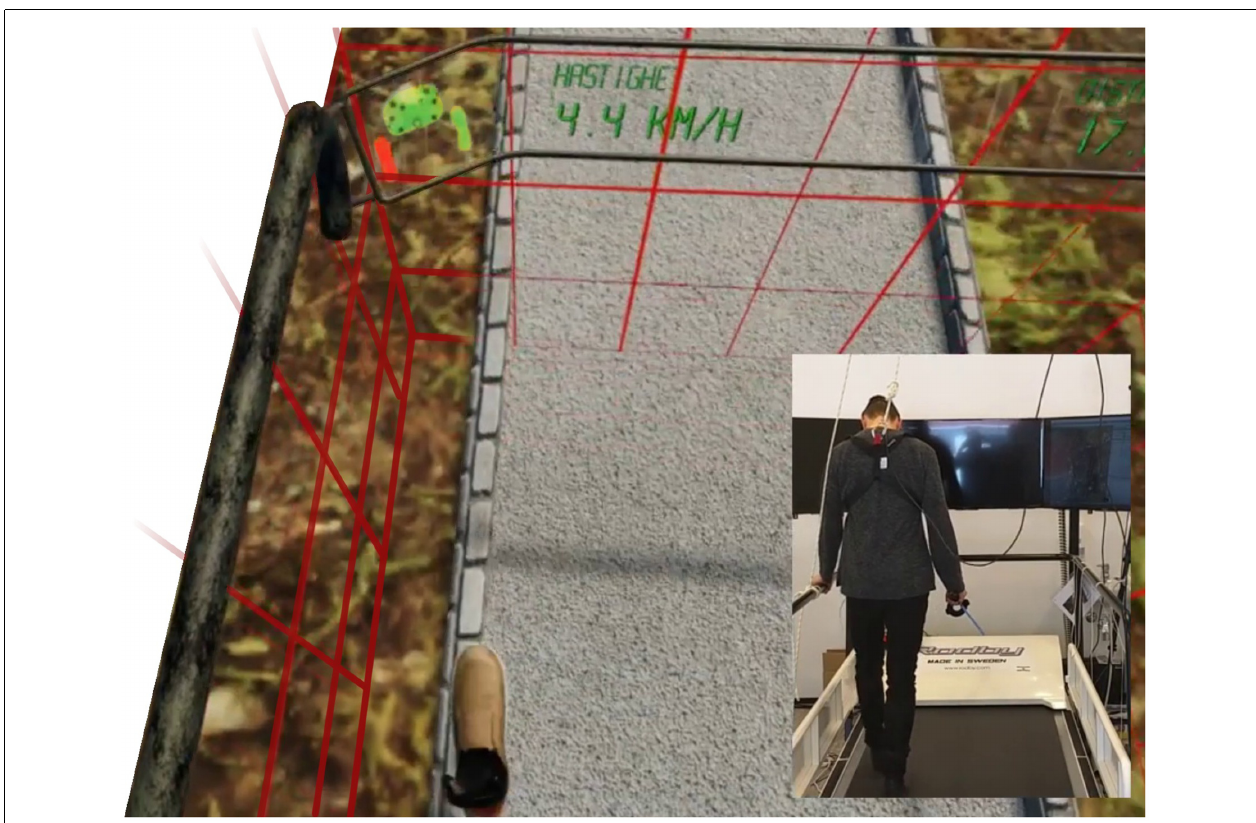
FIGURE 2 | When the player steps toward the limits of the game area, a grid is visualized. If the player steps past the game area, the grid turns red and the treadmill stops automatically. External safety measures such as harness and treadmill railing is